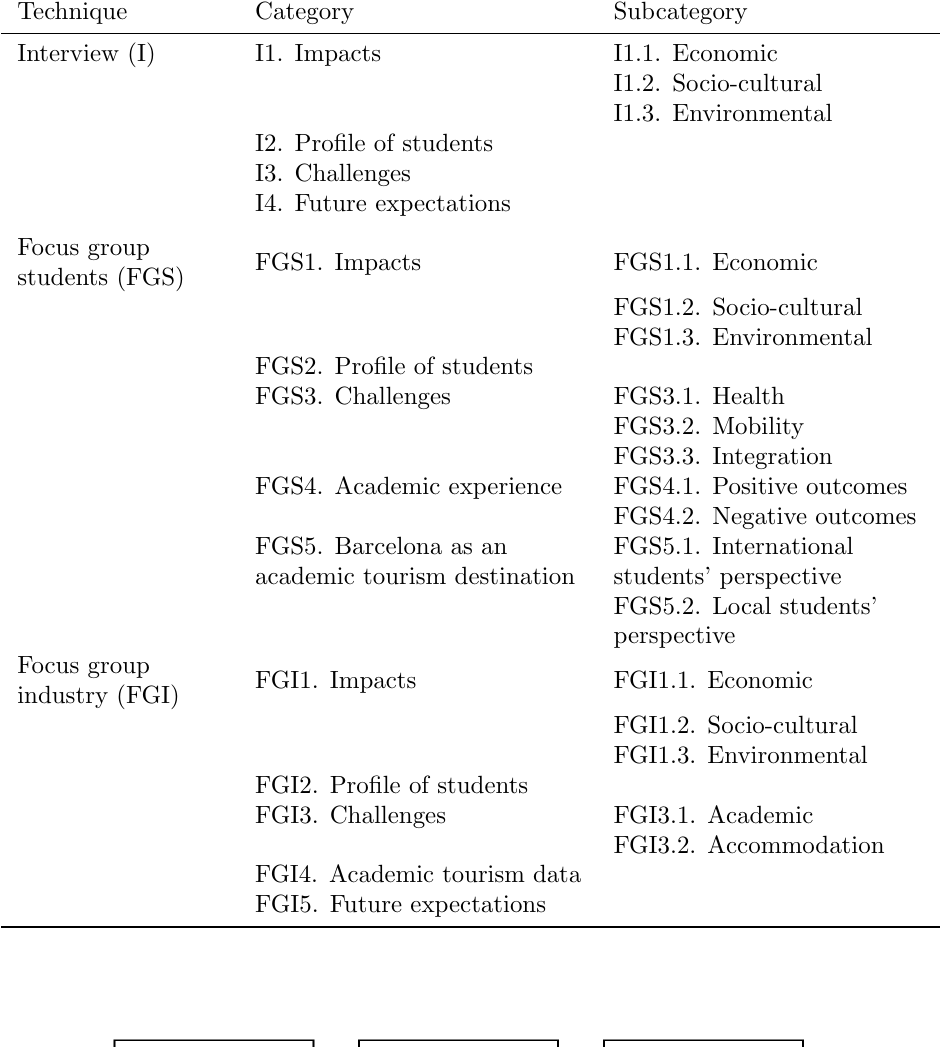
Table 3: Categorisation